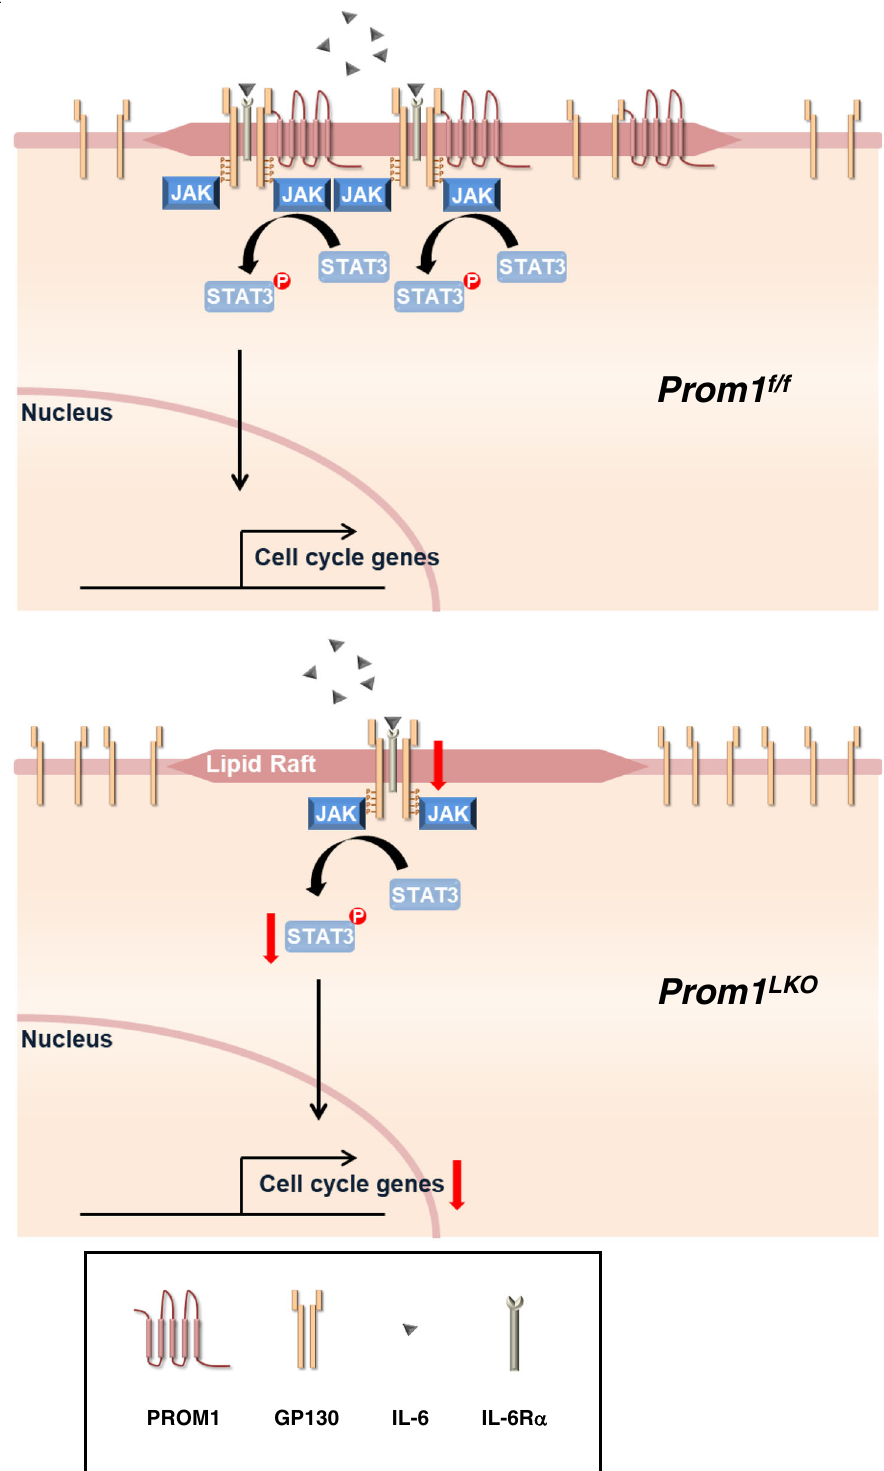
Fig. 8 | PROM1 promotes hepatocyte proliferation through facilitating IL-6- GP130 signaling pathway in lipid rafts during liver regeneration. a After 2/3 partialhepatectomyorCCl 4 injection,PROM1expressionincreasesinhepatocytes. Upregulated PROM1 recruits GP130 into lipid rafts by interacting with GP130.